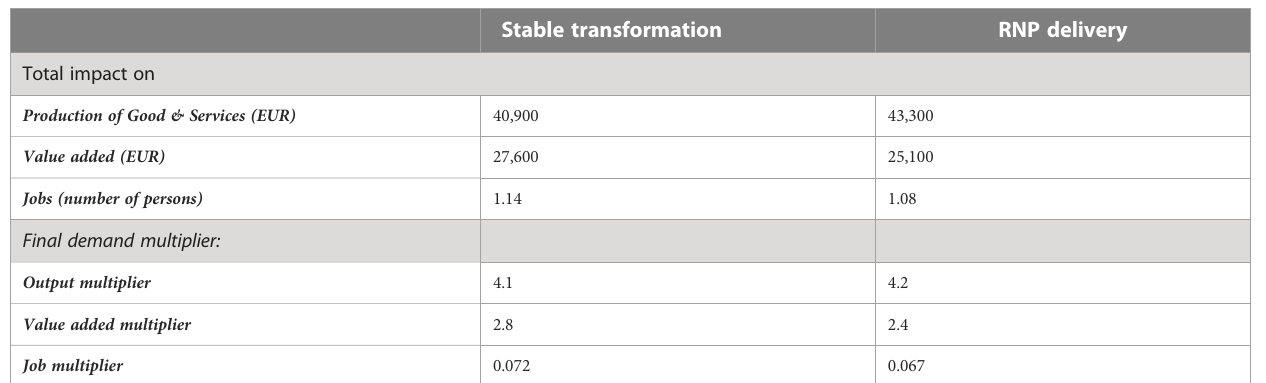
TABLE 5 Economic effects of the two genome editing